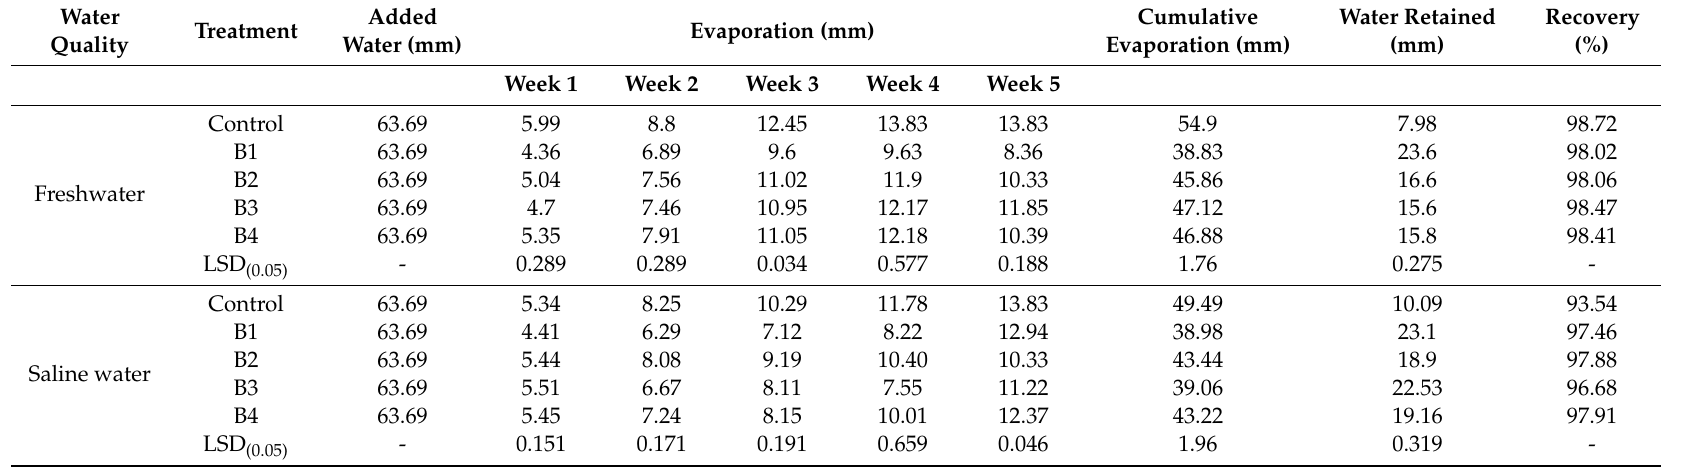
Table 5. Evaporation and water retention after wetting and drying cycles for fresh and saline water